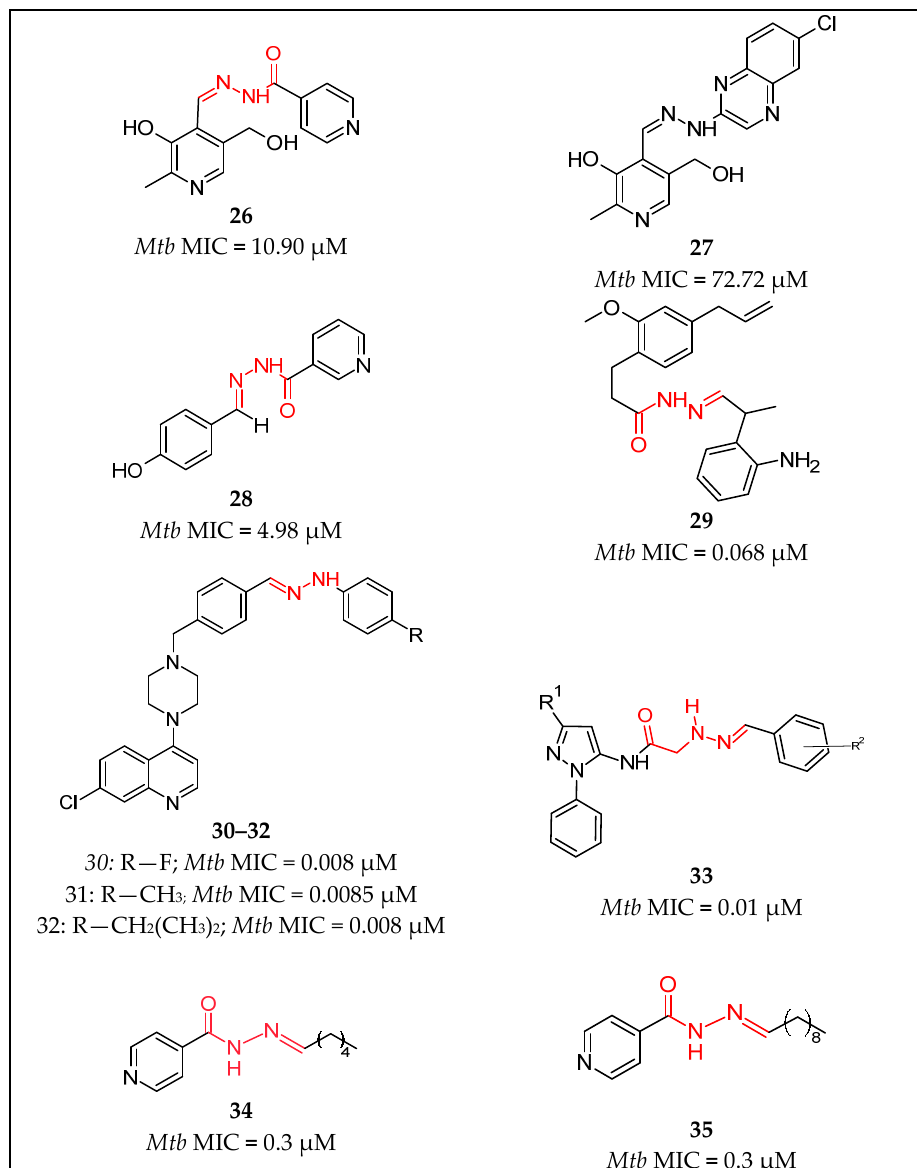
Figure 8. Chemical structures of compounds 26 [51], 27 [51], 28 [52], 29 [53], 30 – 32 [54], 33 [55], 34 [56] and 35 [56].